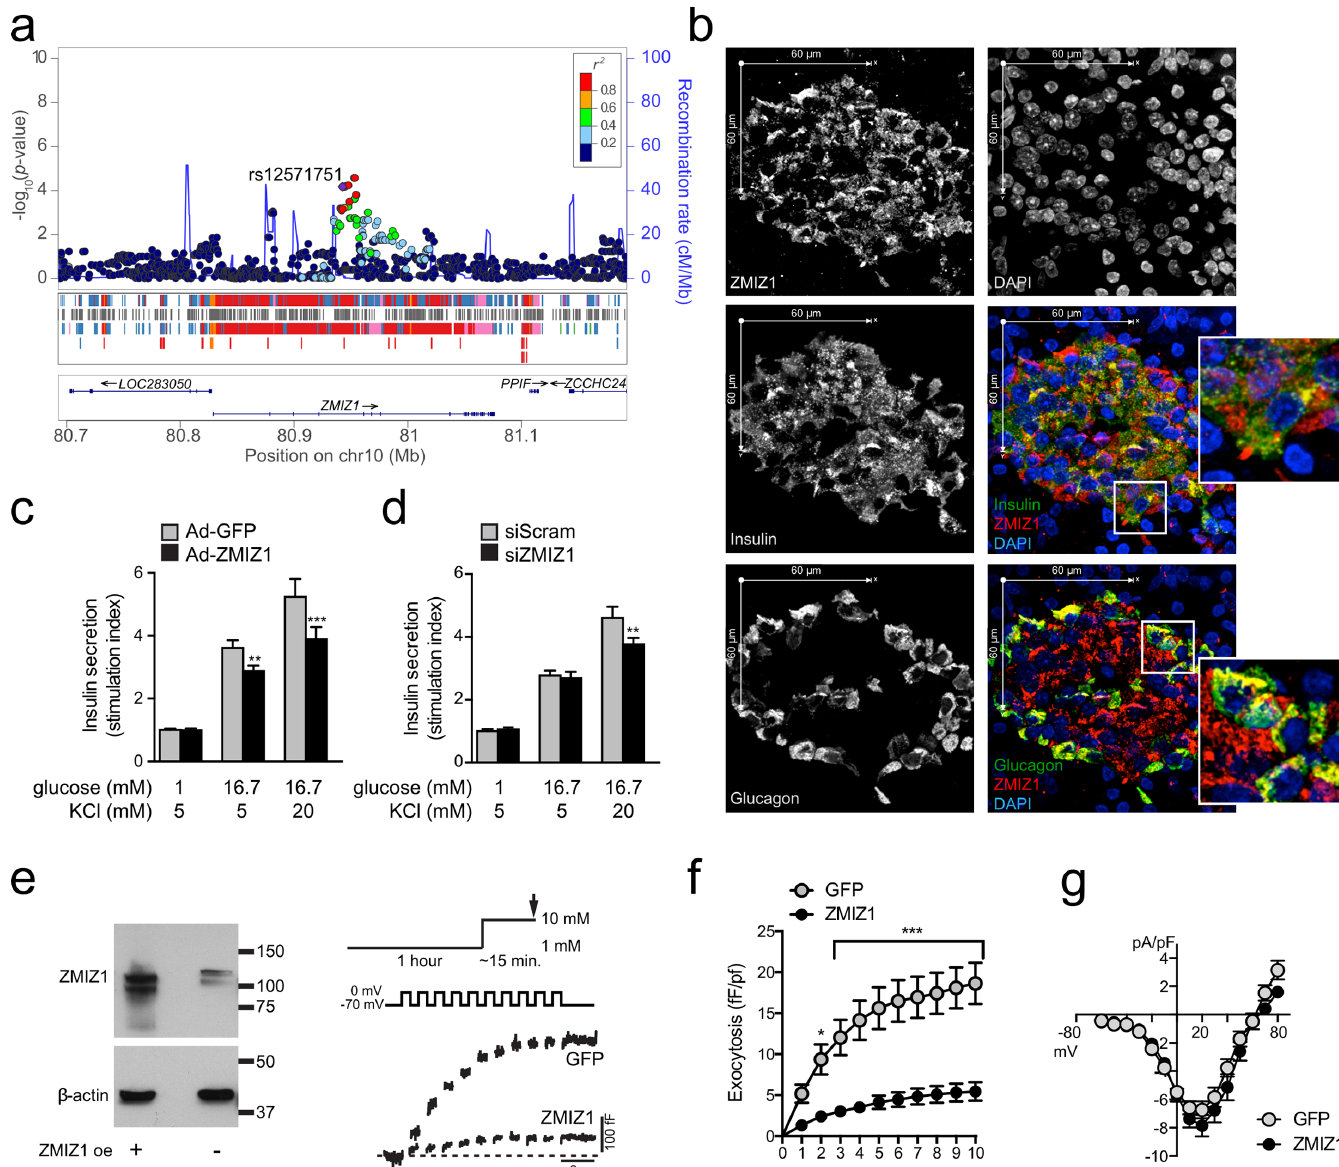
Fig 1. Islet eQTL data identifies ZMIZ1 as a novel gene involved in maintenance of glucose homeostasis in the human islet. (a) Regional plot showing the T2D-associated variant rs12571751 is in strong LD with the lead eQTL variant for ZMIZ1, and overlaps a long stretch of islet enhancer chromatin (denoted as red and blue in the tracks underneath the plot). (b) Immunofluorescence shows ZMIZ1 localizes to the islet within human pancreas sections, with staining in both alpha- and beta-cells. Effect of ZMIZ1 over-expression (c) and knockdown (d) on insulin secretion in human islets, showing significant (p < 0.05) reduction in glucose- and KCl-stimulated insulin secretion during over-expression, and KCl-stimulated insulin secretion only during knockdown. (e) Western blot analysis confirms higher levels of ZMIZ1 after ZMIZ1 over-expression (left). Exocytosis was measured from single human beta-cells, expressing GFP alone or together with ZMIZ1, as increases in membrane capacitance during a train of membrane depolarizations. Representative traces (right) and (f) averaged data from 6 human donors (41 – 44 beta-cells) are show the significant (p < 0.05) reduction in exocytosis in ZMIZ1-transfected beta- cells compared to GFP-controls. (g) Voltage-dependent Ca2+ currents were measured from human beta-cells expressing GFP alone or together with ZMIZ1. The average total Ca2+ charge entry during the depolarization (24 – 27 beta-cells from 3 individuals) was unchanged by ZMIZ1